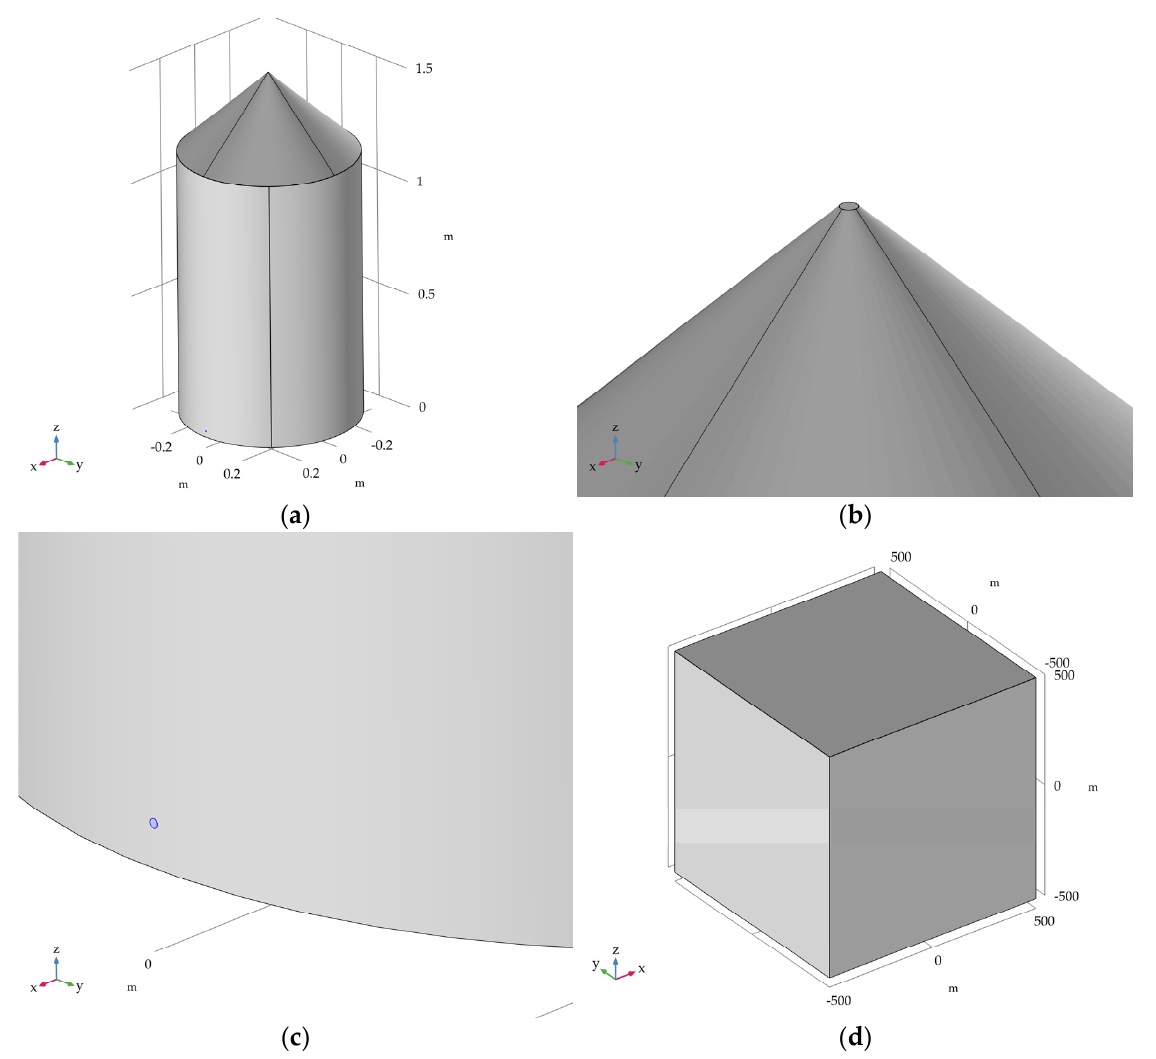
Figure 4. Flowchart of building model.